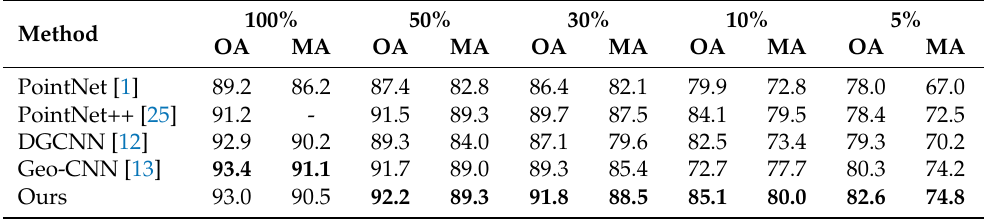
Table 4. Few-shot learning accuracy based on